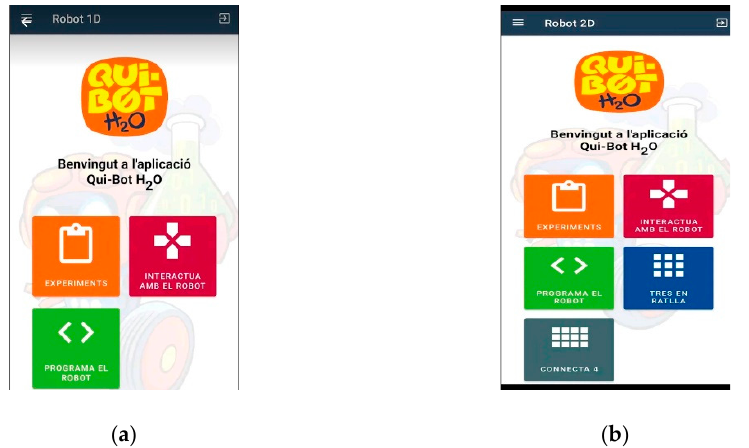
Figure 5. ( a ) Lab Qui-Bot (experiments, interacting with the robot, and programing the robot) and ( b ) Lab2 Qui-Bot (experiments, interactions, robot programming, tic-tac-toe game with the robot, and connect 4 game).